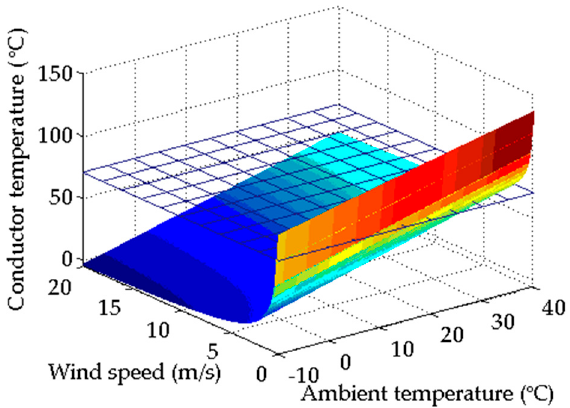
Figure 7. Conductor temperature under different wind speeds and ambient temperatures (I=899 A).